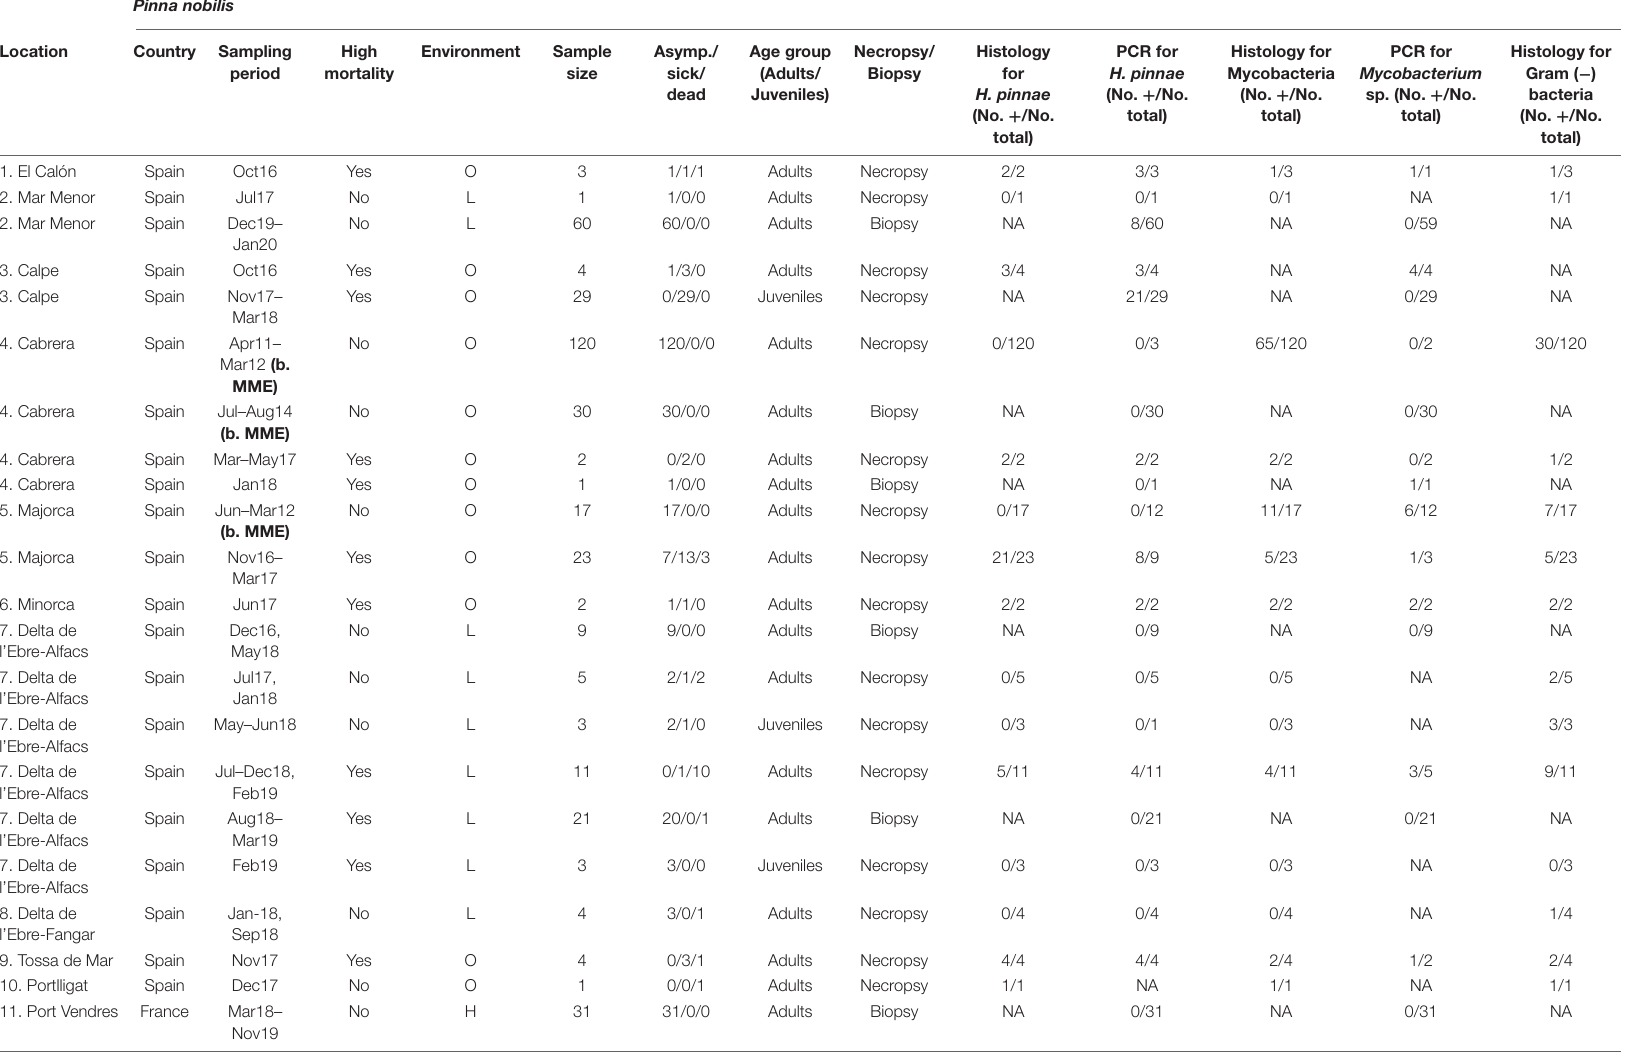
TABLE 1 | Summary of sampling and diagnosis information, including sampling locations; sampling period; whether high mortality had occurred in the sampling location or not; sample size; number of fan mussels asymptomatic, sick and recently dead; age group (adults or juveniles); procedure of tissue removal (necropsy or biopsy); and the diagnostic results for Haplosporidium pinnae , mycobacteria and Gram ( − ) bacteria [No. positive ( + ) cases/No. diagnosed